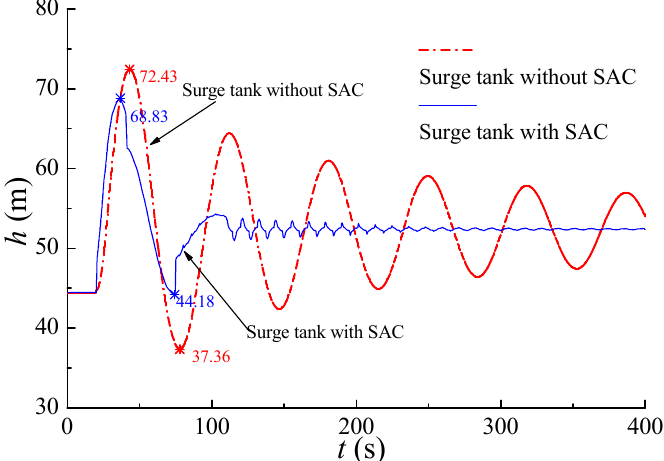
Figure 9. Transient pressure comparison of the surge tanks with or without SAC.